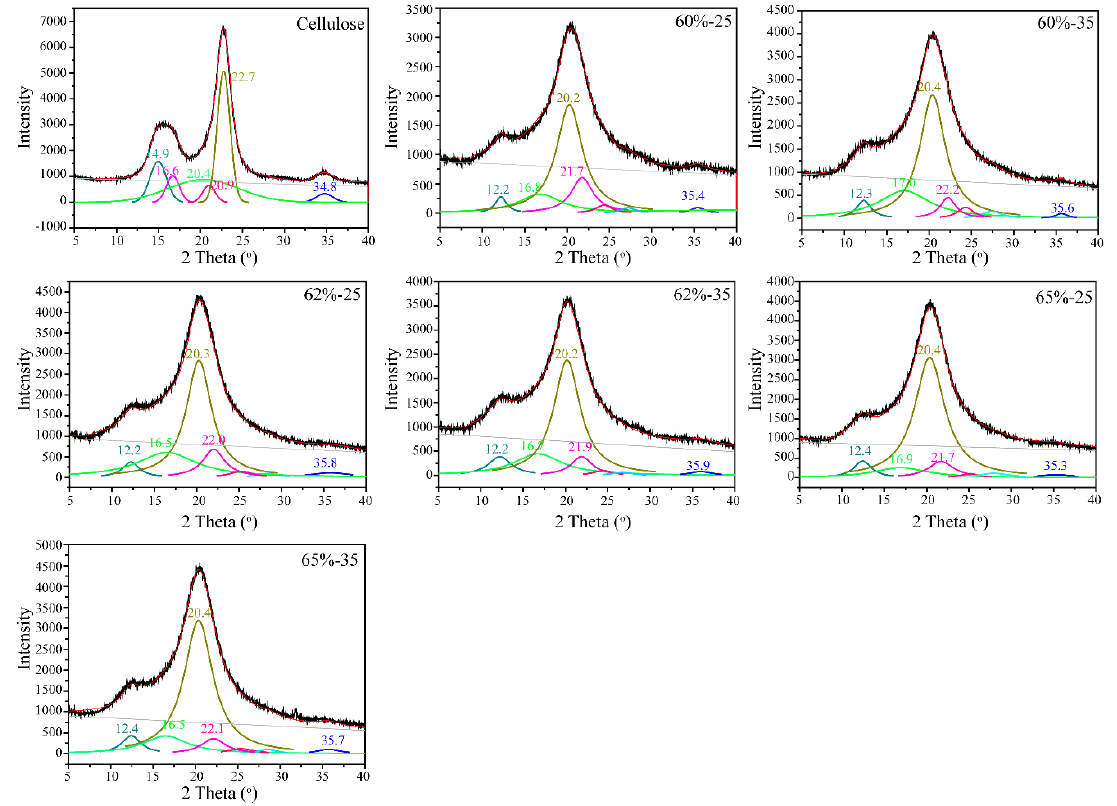
Figure 3. Lorentz deconvolution of the X-ray diffraction (XRD) patterns of cellulose samples.